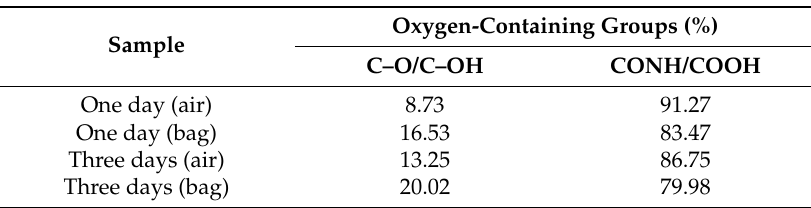
Table 6. Relative amounts of different oxygen-containing groups (%) with storage time and environment